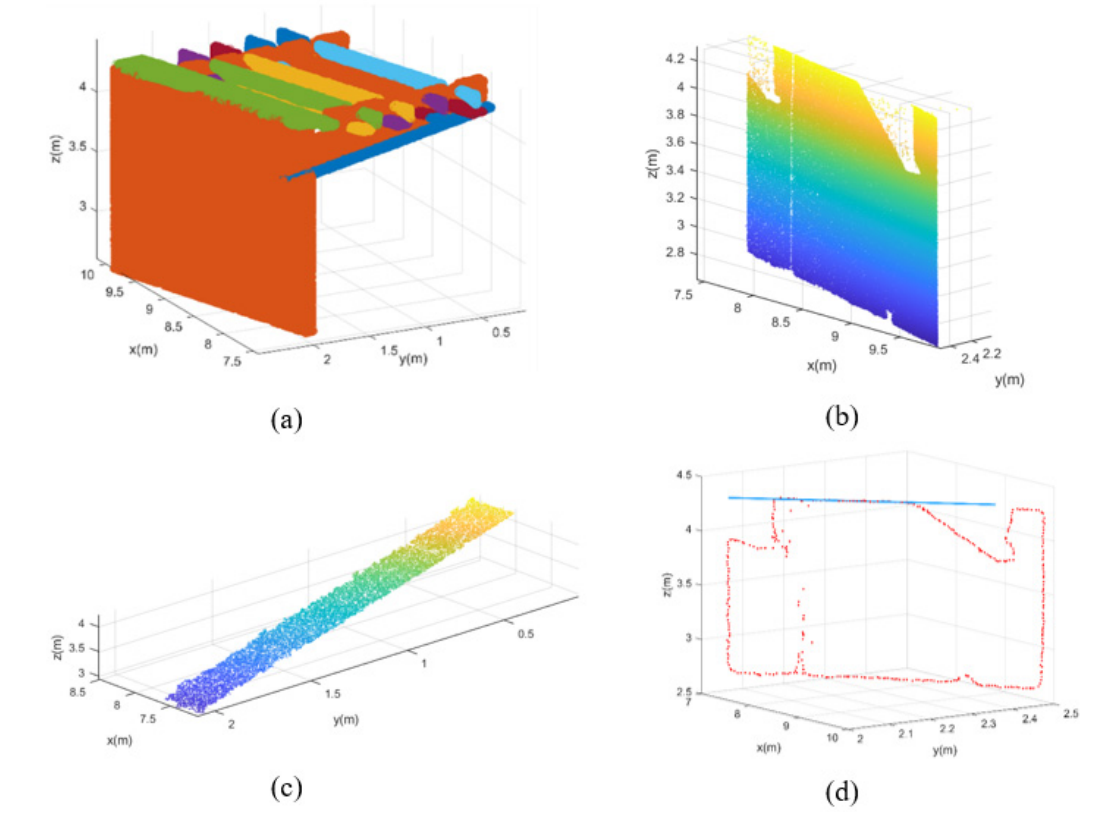
Figure 4. The extraction of the steel cabin: ( a ) example of the robust region-growing algorithm for SBG; ( b ) side surface; ( c ) top surface; and ( d ) top boundary and the line fitted by boundary